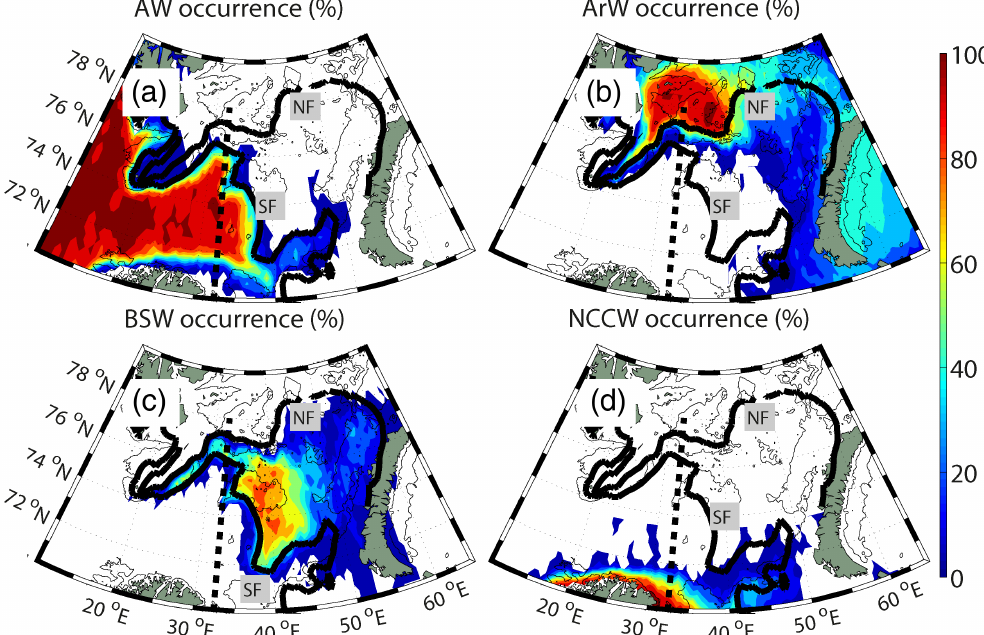
Figure 5. Water Mass Occurrences (%) over the 1980–2011 period in August–September for the 50–100m layer. (a) Atlantic Water, (b) Arctic Water (c) , Barents Sea Water, (d) Norwegian Current Coastal Water. The Southern Front (SF) and Northern Front (NF) (bold black lines), the Vardø section (dashed line), and the 200m isobath (thin black line) are